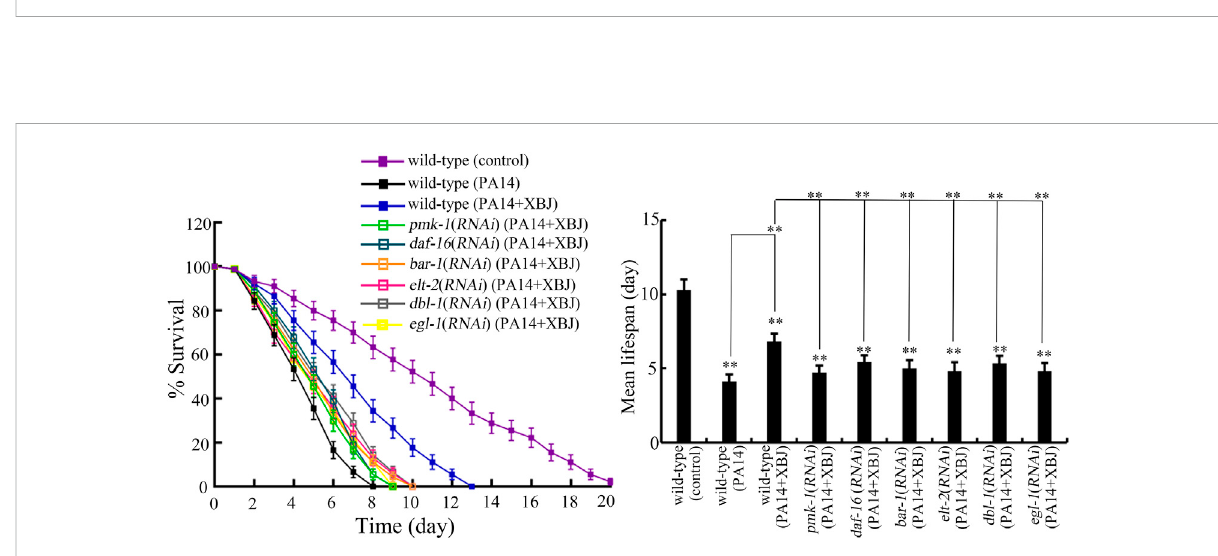
FIGURE 6 RNAi of bar-1 , elt-2 , pmk-1 , dbl-1 , egl-1 , and daf-16 altered the effect of Xuebijing (100%) treatment against P . aeruginosa infection. RNAi was performed after P . aeruginosa infection. XBJ, Xuebijing. ** p < 0.01 vs. wild-type (control) (if not specially